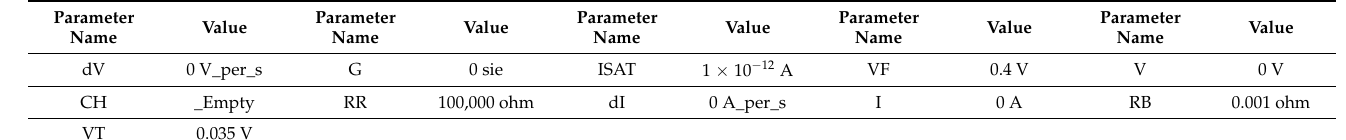
Table A4. Electrical parameters of the diodes—D7, D8 from Figure 6.